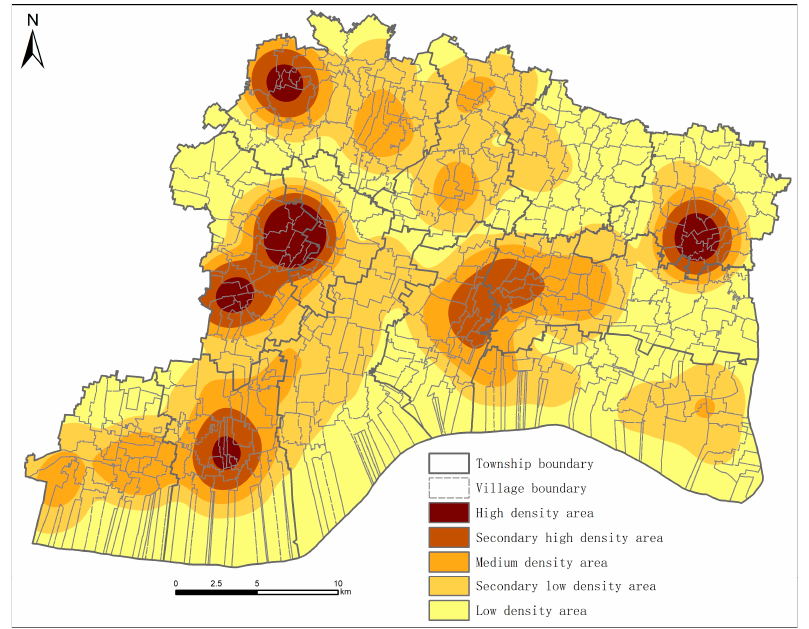
Figure 4. Kernel density analysis of cultivated land leisure service POI in Yuanyang